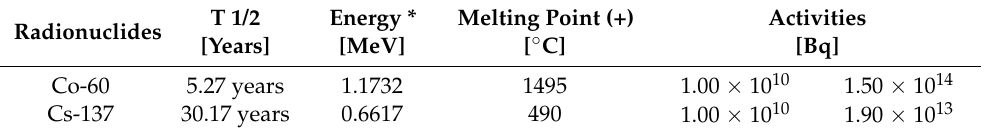
Table 1. Main properties of the two radionuclides considered in the scenarios. T 1/2 Energy * Melting Point (+) Radionuclides [Years] [MeV]